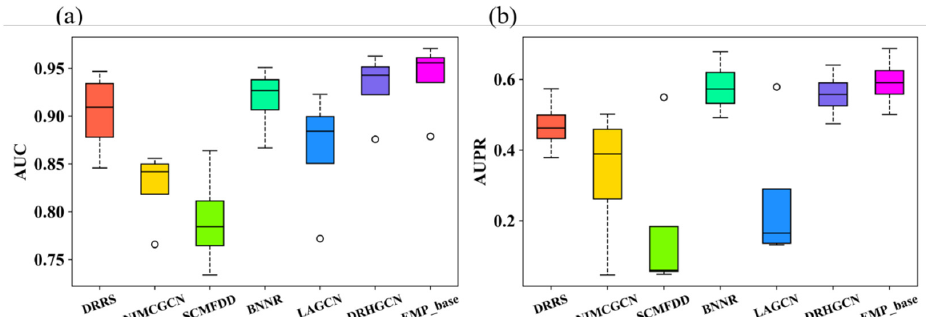
Figure 5. Performance of the baseline model comparison with all methods by 10-fold-cross-validation on four benchmark datasets. ( a ) Average AUC comparison of different methods. ( b ) Average AUPR comparison of different methods.